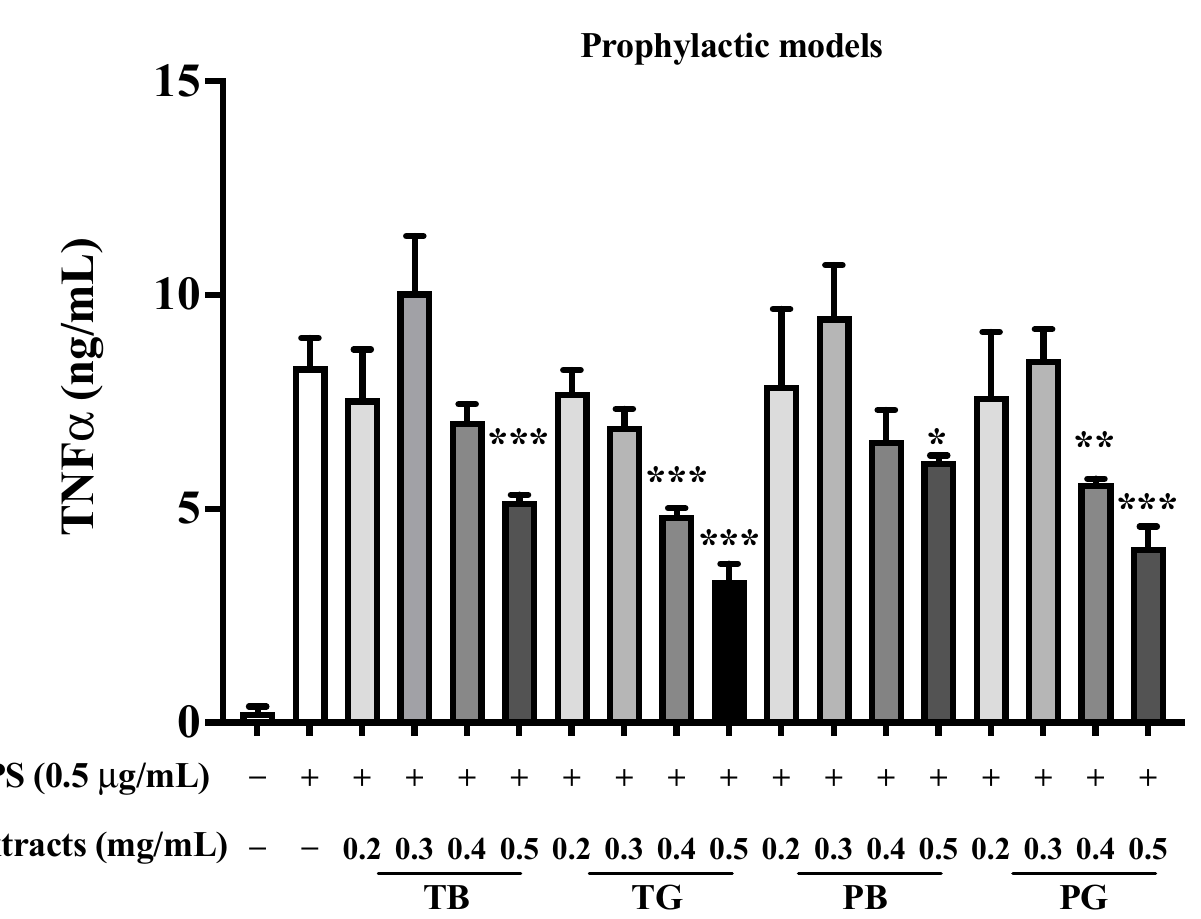
Figure 9. Effect of various teas on TNF- α secretion of LPS-stimulated macrophages in the prophy- lactic model. LPS (0.5 µ g/mL) was added to all groups until assay, except the control group. In the LPS-stimulated macrophages, the cells were incubated in the medium without/with various concentrations of tea samples. In our prophylactic model, the pretreatment of four tea extracts was performed for 8 h. Then LPS (0.5 µ g/mL) was added and co-incubated for the remaining 16 h to explore the prophylaxis of the four teas. The data were presented as mean ± SE of three experiments. * p < 0.05; ** p < 0.01; *** p < 0.001. TNF- α : tumor necrosis factor- α ; LPS: lipopolysaccharide; T: Taiwan Tea Experiment Station No. 12; P: purple shoot tea; G: green tea and B: black tea.